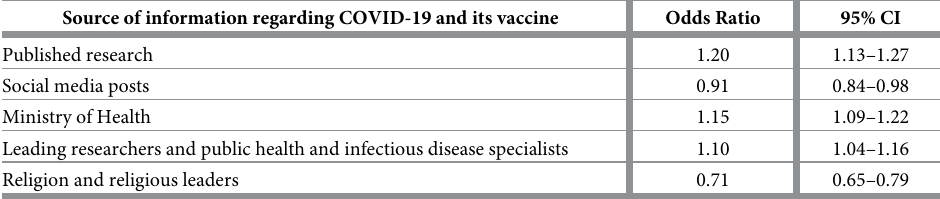
Table 7. Determining the relationship between our participants’ source of information regarding the COVID-19 vaccine and their willingness to recommend the